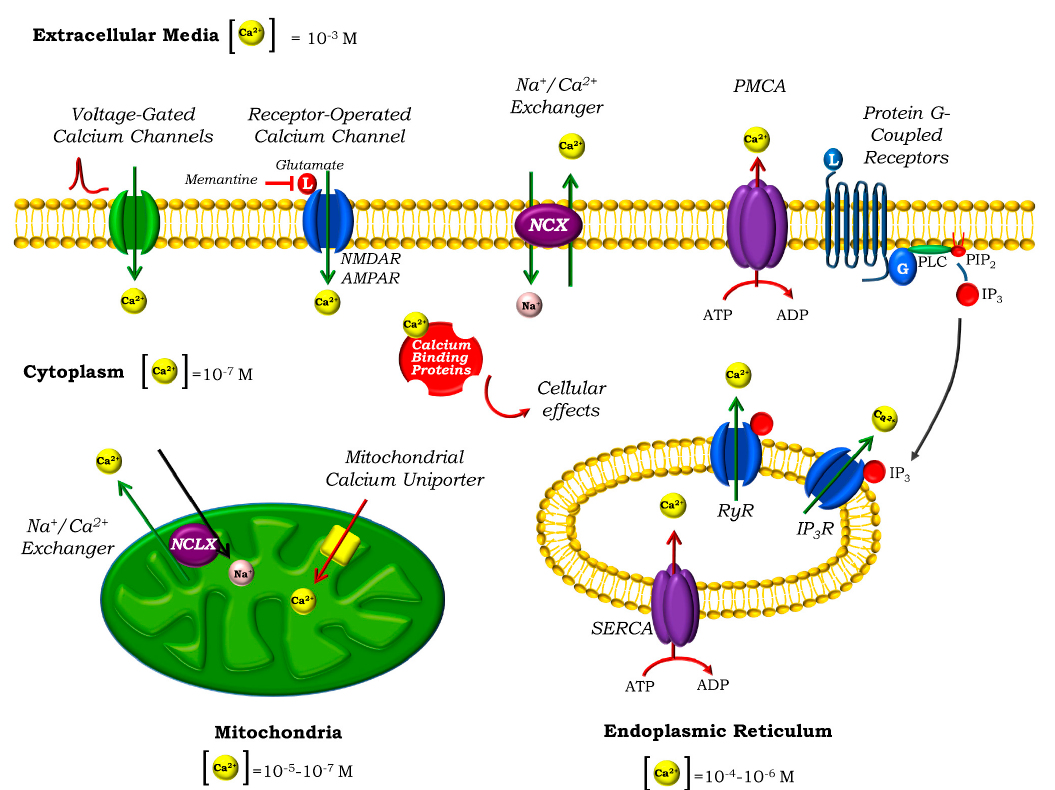
Figure 1. Calcium homeostasis in neurons. Ca 2 + signals are shaped by a fine regulation between cytosolic Ca 2 + influx and e ffl ux. The main sources for Ca 2 + influx are the extracellular media and intracellular stores such as the endoplasmic reticulum (ER). Depolarisation of the neurons leads to the opening of the voltage-gated calcium channels (VGCCs) in the plasma membrane, while ligand binding triggers the opening of the receptor-operated calcium channels (ROCs). AMPA and especially NMDA receptors, both activated by glutamate, are the most important ROCs in the neurons. AD-approved drug memantine is an inhibitor of the NMDARs. Ca 2 + can also be released to the cytosol from the ER, after activation of the Ryanodine or inositol 1,4,5-triphosphate (IP 3 ) receptors. Binding of a ligand (such as glutamate) to a G-protein-coupled receptor in the plasma membrane (such as specific metabotropic glutamate receptors) activates phospholipase C (PLC), leading to the cleavage of the membrane phospholipid phosphatidylinositol 4,5-bisphosphate (PIP 2 ), resulting in the release of the soluble second messenger IP3, that di ff uses through the cell and binds its receptor. Cytosolic Ca 2 + binds specific Ca 2 + binding proteins, which transduce the signal to its final e ff ectors. Excess cytosolic Ca 2 + is removed from the cytosol by di ff erent mechanisms: (i) e ffl ux through the plasma membrane by the Na + / Ca 2 + exchanger NCX and the plasma membrane Ca 2 + -ATPase (PMCA), (ii) uptake to the ER by the sarco / endoplasmic reticulum Ca 2 + -ATPase (SERCA), (iii) uptake to the mitochondria by the mitochondrial Ca 2 + uniporter MCU and (iv) bu ff ering by Ca 2 + binding proteins. Mitochondrial Ca 2 + homeostasis is maintained by the e ffl ux through the mitochondrial Na + / Ca 2 + exchanger